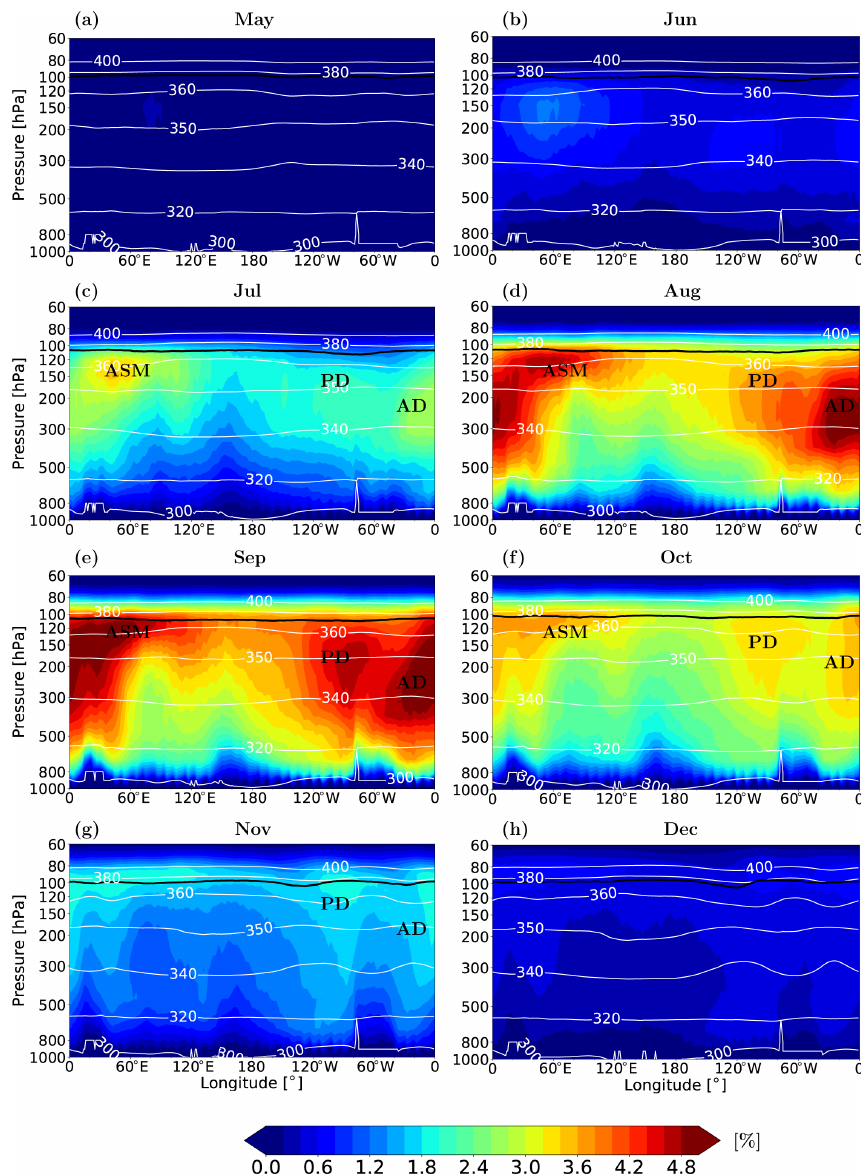
Figure 7. Longitude–pressure cross section along the latitude of 10 ◦ S of monthly mean NH extratropical young ( < 3 months) AMF (color shading) during 1999–2017. White lines show isentropic levels; the black line shows the WMO tropopause. ASM, PD, and AD respectively indicate the rough locations of the Asian summer monsoon region, Pacific westerly ducts, and the Atlantic westerly